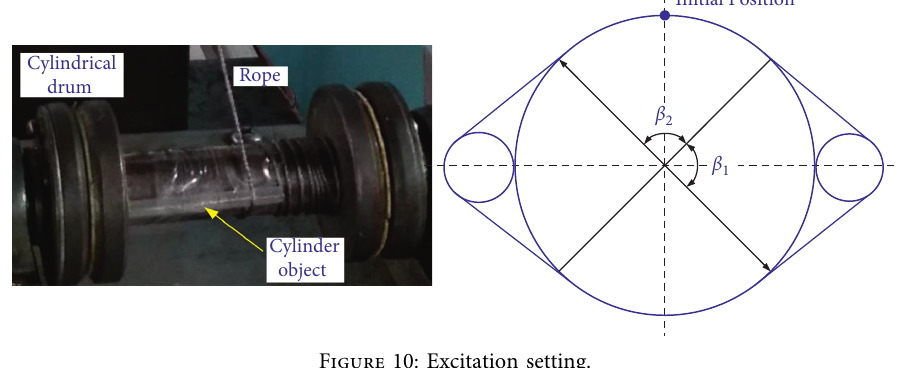
Figure 10: Excitation setting.